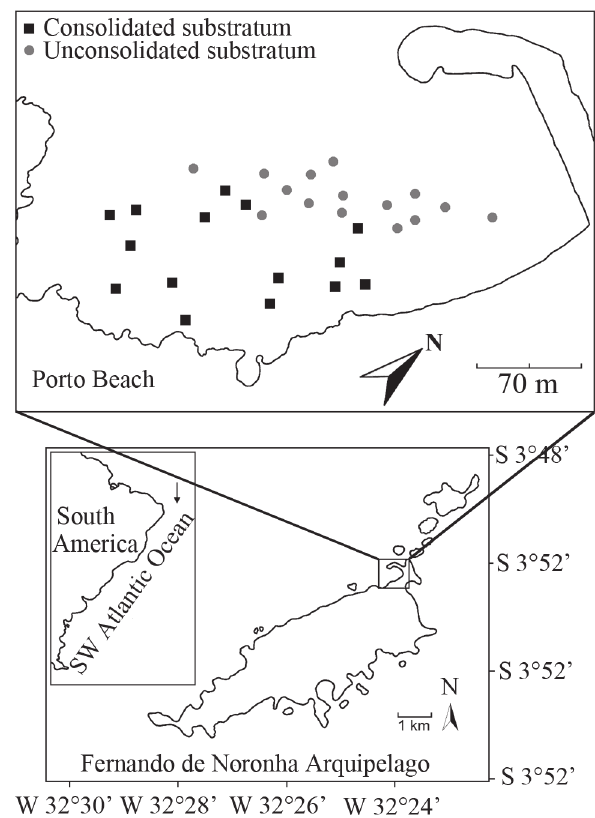
Fig. 1. Map of the Fernando de Noronha Archipelago showing the study area (Porto Beach) and permanent sampling